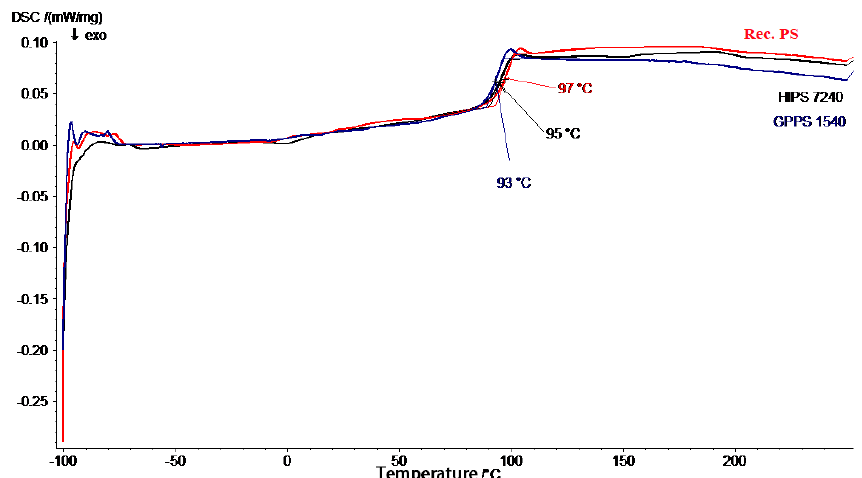
Figure 1. Differential scanning calorimetry (DSC) plot for high impact polystyrene (HIPS) 7240, general purpose polystyrene (GPPS) 1540, and recycled polystyrene (PS).